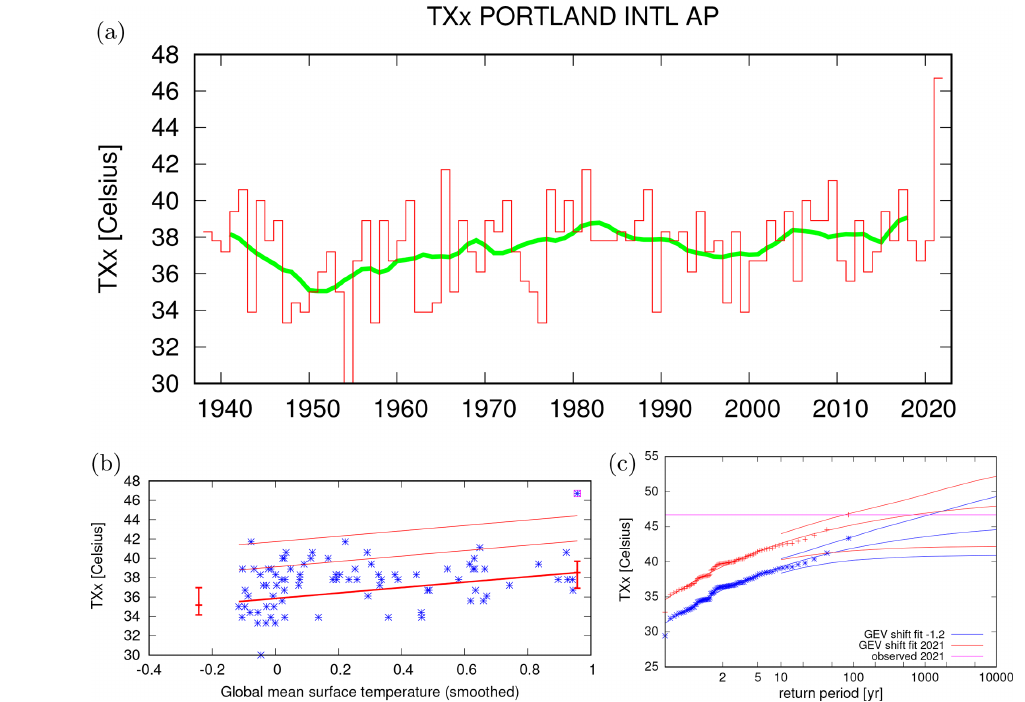
Figure 9. (a) Time series of observed highest daily maximum temperature of the year at Portland International Airport. (b, c) As Fig. 8 but for the station data at Portland International Airport. Source: data GHCN-D (Menne et al., 2012); fit: KNMI Climate Explorer (https: //climexp.knmi.nl, last access: 22 April 2022).